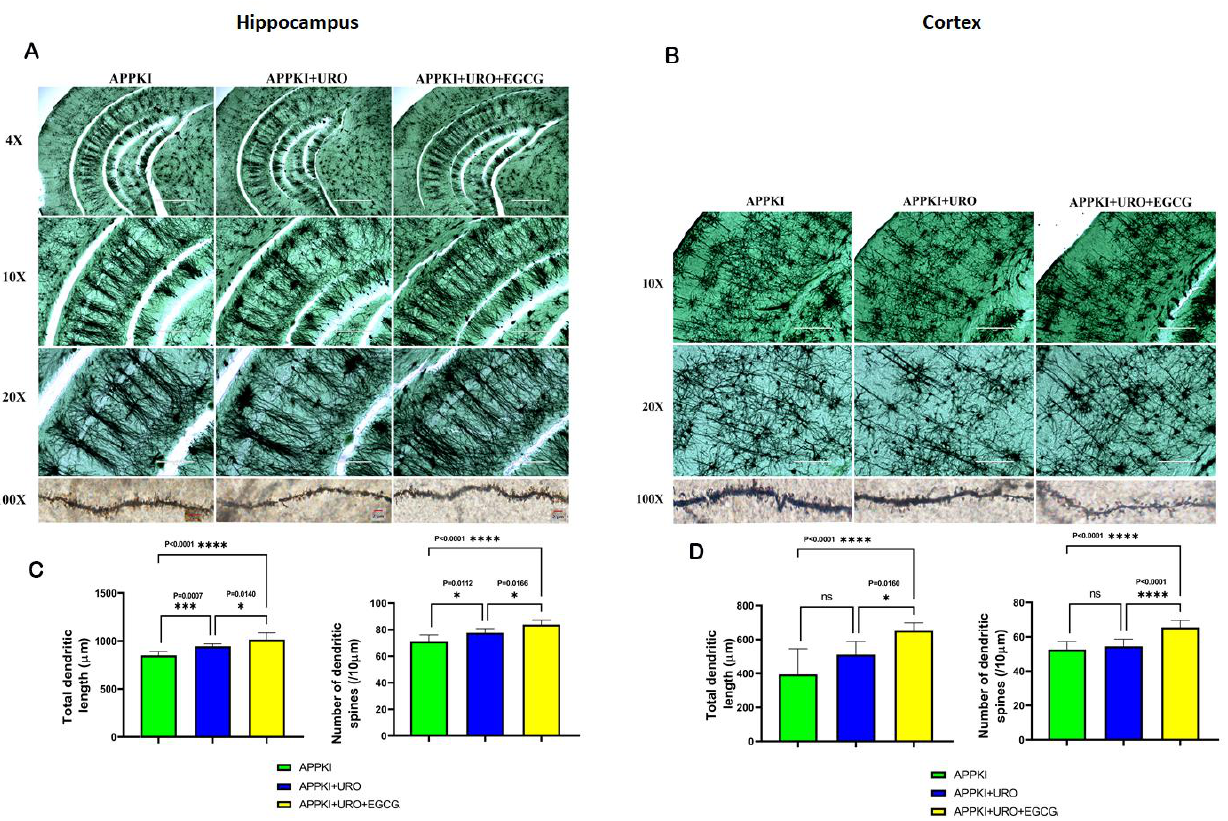
Figure 15. Golgi – Cox staining representing hippocampal and cortical dendritic spine density in the brains of seven-month-old hAbKI mice and treated hAbKI mice with Urolithin A and EGCG. ( A , B ) Represents Golgi – Cox staining at 4×, 10×, 20× and high magnification at 100×. ( C , D ) Represents quantification of spine density in the untreated hAbKI and treated hAbKI mice with Urolithin A and EGCG. Significantly reduced dendritic spines were found in untreated hAbKI mice relative to treated hAbKI mice with Urolithin A and EGCG.